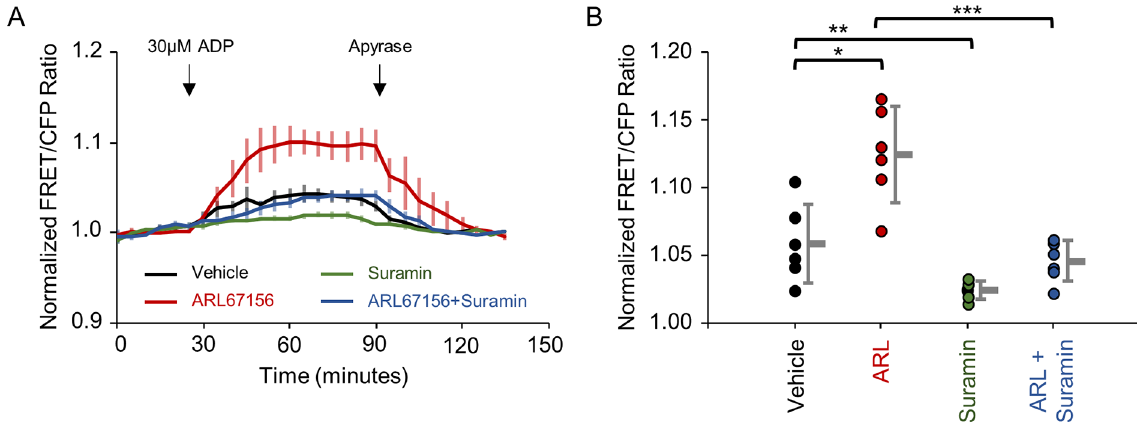
Fig 7. ADP-stimulated releaseof ATP releasefrom Neuro2A cells may be mediated in part by purinergic pathways. (A) Average time course of ecAT3.10 ratio signal (baselinenormalized, n = 6 experiments) from Neuro2Acells that were imagedunder static bath conditions. 30 μ M ADP was added to stimulate release of ATP. Pretreatment with 100 μ M ARL67156(red) potentiated the responsein comparisonto vehicletreatment (black). Treatment with 3.3 μ M suramin(green) attenuated extracellular ATP levels comparedto vehicle(black), and treatment with suraminin the presenceof ARL67156 (blue) attenuated the releaseof ATP comparedto ARL67156 alone (red). Apyrase addition degradesextracellular ATP confirming a reversible ATP-specific sensor response. (B) Summary of cell averaged peak responses for individual experiments. Peak responses: vehicle, 1.06 ± 0.01; ARL67156, 1.13 ± 0.01; suramin, 1.027 ± 0.002; ARL67156 plus suramin, 1.048 ± 0.006, mean ± sem. t-test, * p = 0.004, ** p= 0.02, *** p = 0.0004. n = 6, 2 independent